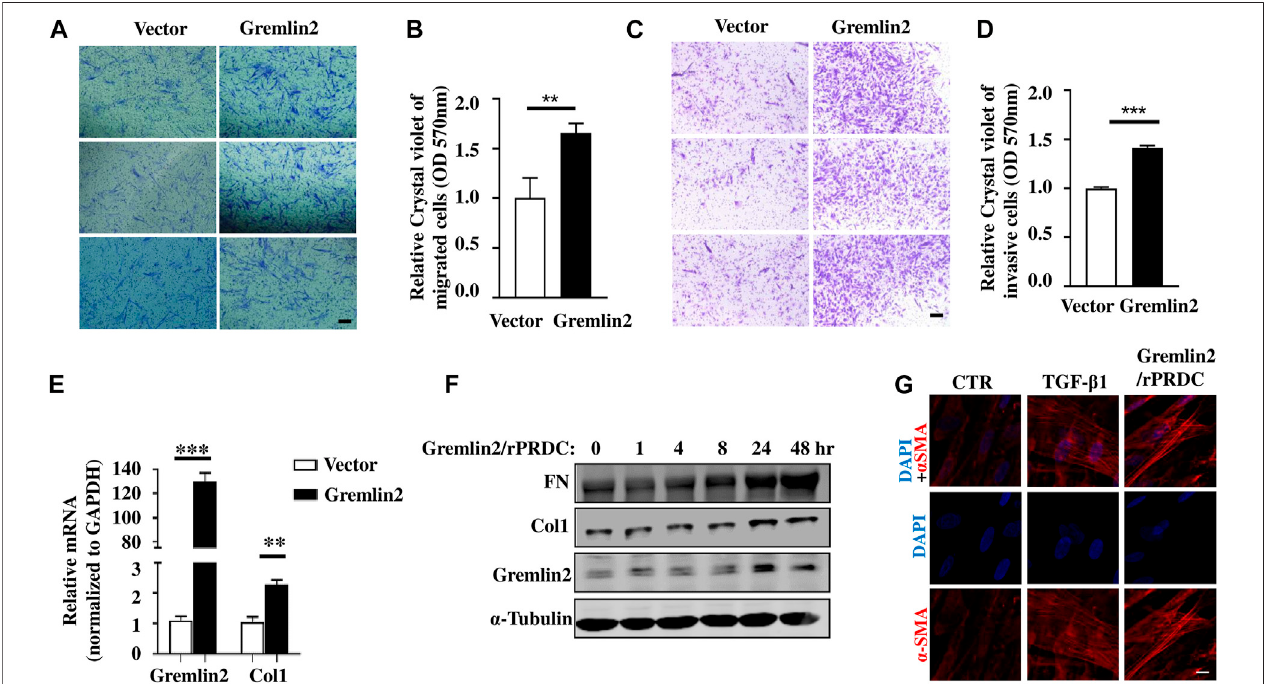
FIGURE 6 | Overexpression of Gremlin2 increases the migration and invasion of fi broblasts. (A) Transwell cell migration experiment after Gremlin2 overexpression in fi broblasts. The lower chamber was stained with crystal violet 24 h later, and three fi elds were randomly selected for imaging under 100 × magni fi cation. Scale bar (cid:2) 100 µm. The experiment was repeated three times. (B) The value of OD570 after elution of crystal violet, normalized to that of the control group, ** p (cid:2) 0.072. Unpaired student t test. (C) Transwell cell invasion experiment after 1:32 matrix glue was laid. After 48 h, crystal violet staining was carried out on the lower layer of the chamber. Scale bar (cid:2) 100 µm. The experiment was repeated three times. (D) The value of OD570 after elution of crystal violet, normalized to that of the control group. *** p < 0.001.Unpairedstudentttest. (E) HFL-1cellstransfectedwithGremlin2expression plasmidfor24 h,andmRNAwasextracted. Then,real-timequantitativePCR was performed to detect the corresponding mRNA expression levels. Using student ’ s t-test, *** p < 0.001, ** p < 0.01. Scale bar (cid:2) 100 µm. (F) Recombinant human PRDC(rPRDC)/GREM2wasaddedtoHFL-1cellsfor0,1,4,8,24,and48 h,thenwesternblottingwasperformedtodetecttheexpressionof fi bronectin,collagen1,and Gremlin2. (G) TGF- β 1 or recombinant human PRDC (rPRDC)/GREM2 was added to HFL-1 cells for 48 h, then immuno fl uorescence was performed to detect the expression of α -SMA (Red). DAPI (Blue) shows the nucleus. Scale bar (cid:2) 20µm. All the experiments have been repeated three